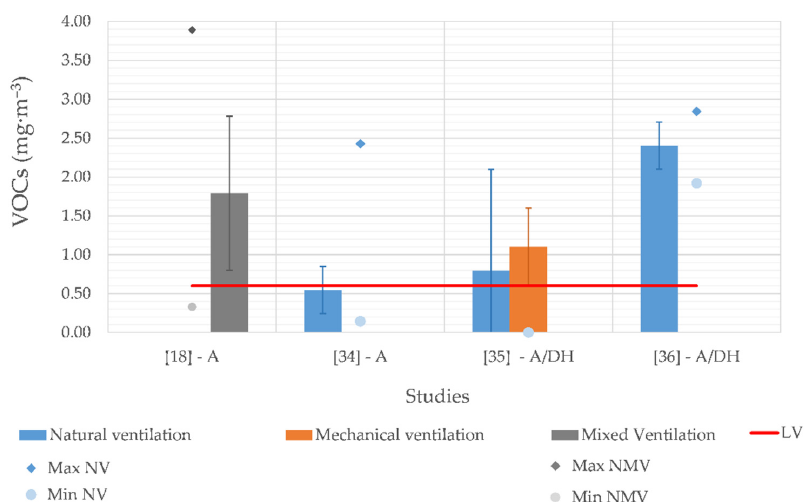
Figure 6. Volatile Organic Compounds levels monitored during the sleeping period at bedrooms in different types of building (A—apartment; A/DH—mixed (apartment and detached house); DH—detached house) and different types of ventilation settings (NV—natural; mechanical—MV; mixed—NMV). Bars provide mean values (along with standard deviation when available). LV stands for the limit value established by the Portuguese Ordinance no. 353-A/2013 [44], and max and min stand for maximum and minimum values,